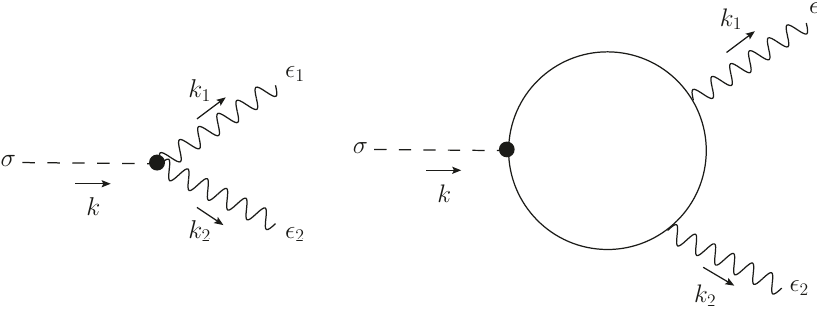
Figure 4 . Leading contributions to M TAA , i.e., T (cid:22) - (cid:22) A (cid:21) - (cid:22) A (cid:20) correlation function ( (cid:27) decay into two (cid:22) gauge bosons). [Left] M : the gauge kinetic term in eq. (C.33) is inserted. [Right] M : the F 2 fermion mass term in eq. (C.33) is inserted. There is the other contribution with the external gauge bosons